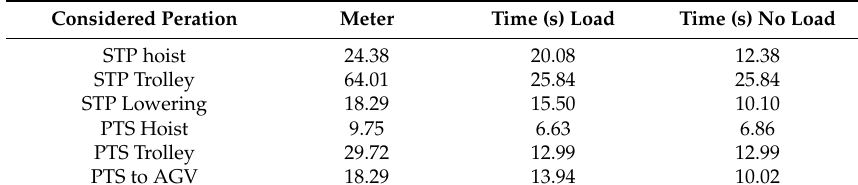
Table 1. The ship to shore (STS) crane’s speed and time.